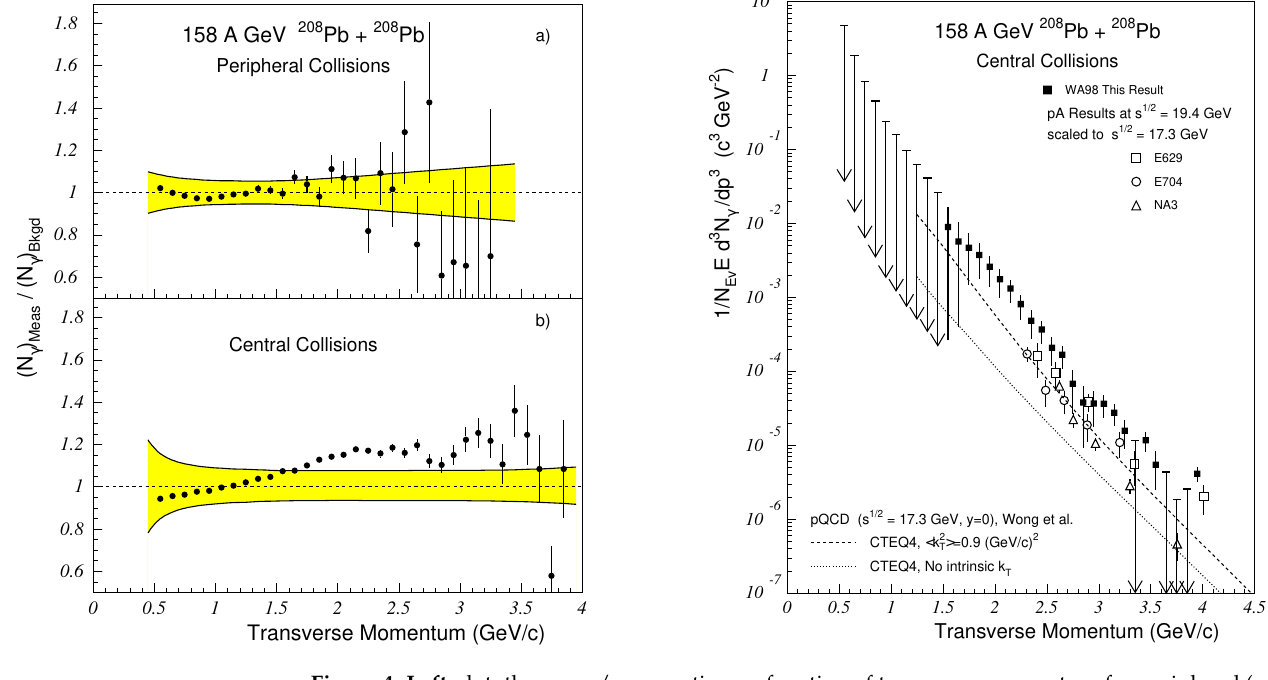
Figure 4. Left plot: the γ Meas / γ Bkgd ratio as a function of transverse momentum for peripheral (part (a)) and central (part (b)) 158 A GeV 208 Pb+ 208 Pb collisions. The errors on the data points indicate the statistical errors only. The p T -dependent systematical errors are indicated by the shaded bands ( 1 + σ L σ U ). (Note: upper and lower errors are inverted for display purposes.) ≡ − direct photon multiplicity for central 158 A GeV 208 Pb+ 208 Pb collisions. The error bars indicate the combined statistical and systematical errors. Data points with downward arrows indicate unbounded 90% CL upper